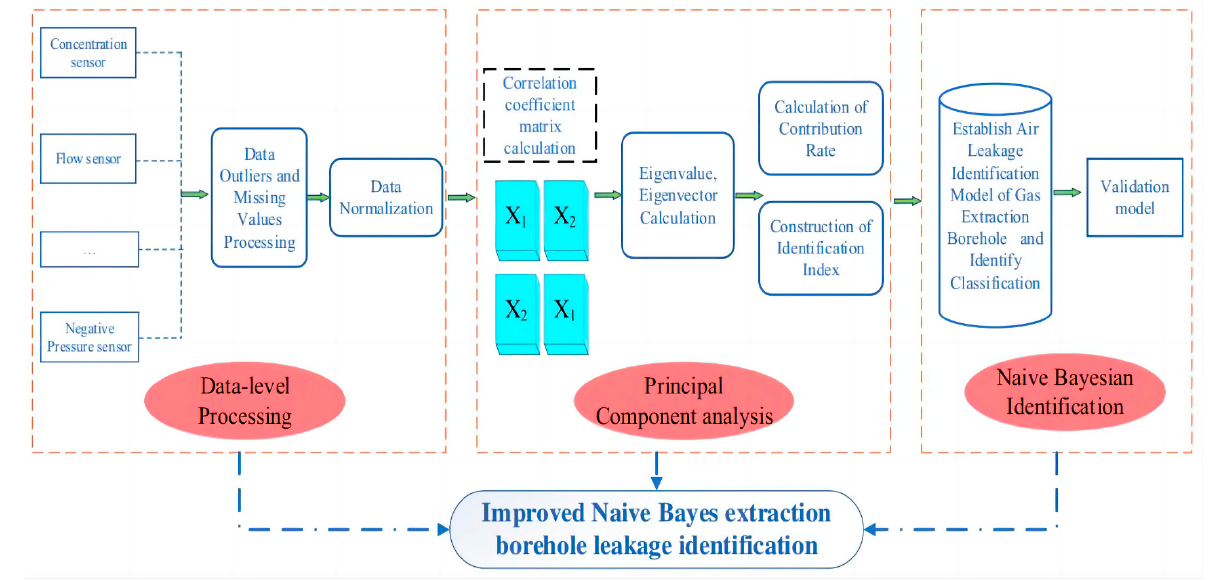
Figure 9. Flow diagram of building the model in 2022 [87].